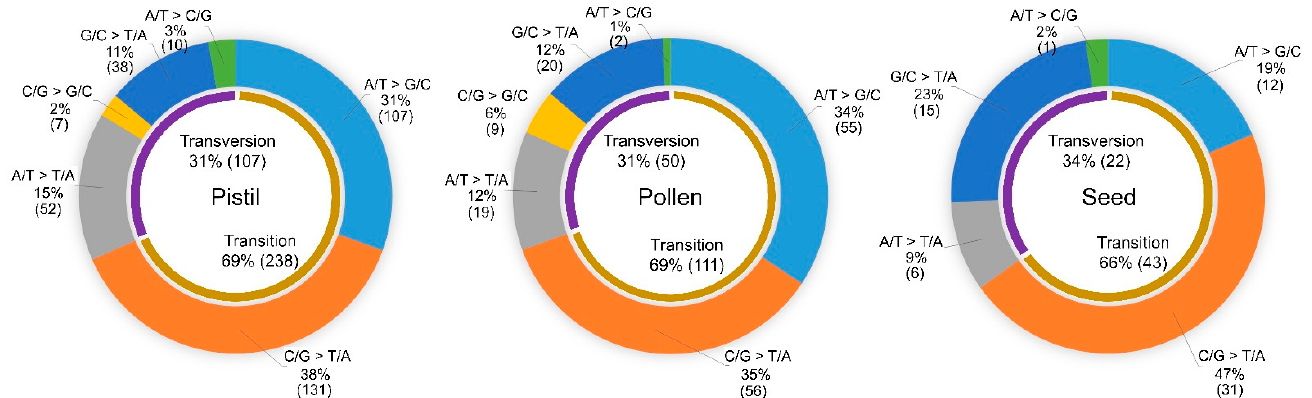
Figure 3. Comparison of single-base substitution (SBS) compositions between progeny from crosses using irradiated pistils, pollen, and seeds. The number of SBSs was indicated in parenthesis.